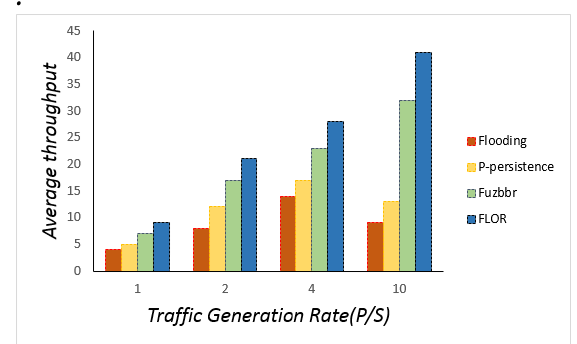
Figure 15. Throughput for different traffic generation